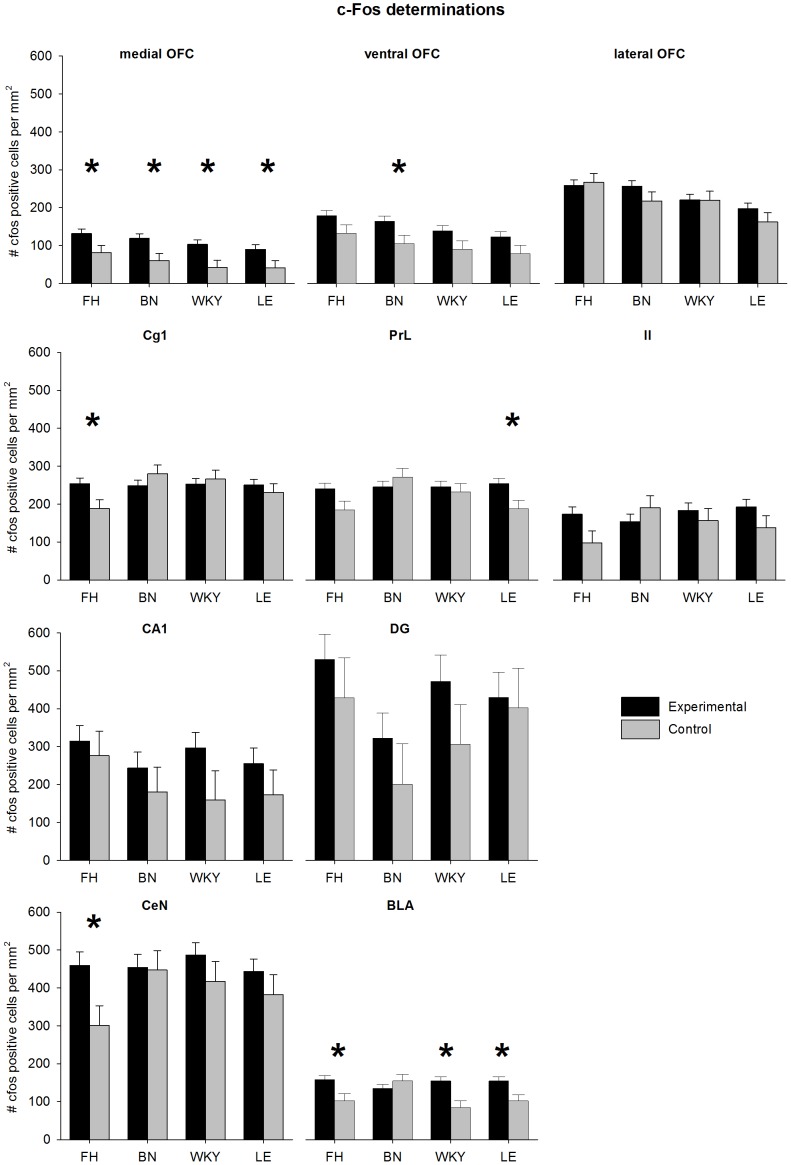
Amount of c-Fos positive cells in different brain areas during conditioned fear after Pavlovian fear conditioning.For each strain the experimental group (n = 10) is compared to control animals of that same strain (n = 4). Data are presented as estimated marginal means ±SEM. * Q-value <0.05 between the experimental and control. FH =  Fawn Hooded, BN =  Brown Norway, WKY =  Wistar Kyoto and LE =  Lewis, OFC =  orbitofrontal cortex, Cg1 =  cingulated area 1, PrL =  prelimbic cortex, IL =  infralimbic cortex, BLA =  basolateral amygdala, CeN central nucleus of the Amygdala, CA1 =  CA1 field hippocampus, DG =  dendate gyrus.